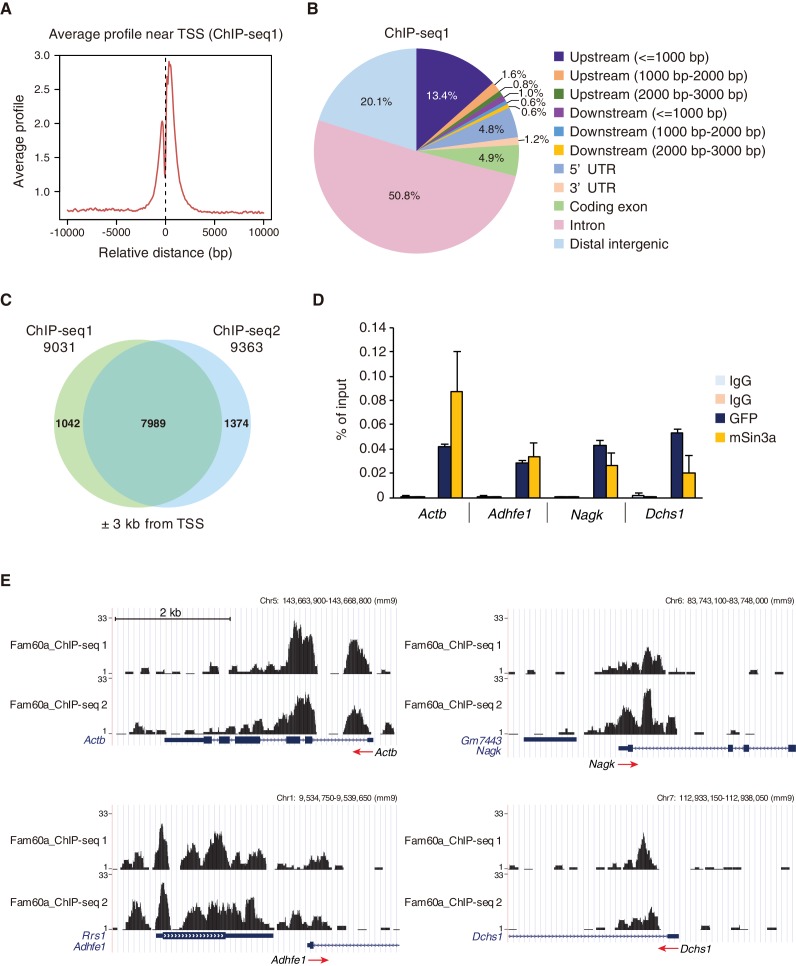
Genome-wide localization of Fam60a to gene promoters.(A) Average binding profile for Fam60a-Venus at the TSS region of all genes with binding peaks identified by ChIP-seq analysis of E9.5 transgenic embryos with antibodies to GFP. Distance is expressed relative to the TSS. (B) Peak distribution for ChIP-seq analysis as in (A). About 80% of peaks were localized to gene loci. UTR, untranslated region. (C) Venn diagram showing the overlap in Fam60a target genes (those with binding peaks within ±3 kb of the TSS) for two independent ChIP-seq analyses (ChIP-seq1 and ChIP-seq2). (D) ChIP-qPCR analysis of the binding of Fam60a-Venus and Sin3a to the TSS regions of the indicated genes in E9.5 transgenic and WT embryos, respectively. The pale blue and orange bars represent IgG controls for antibodies to GFP and to Sin3a, respectively. Data are expressed as percentage of input and are means ± s.d. for three independent experiments. Actb was examined as a positive control. (E) Examples of Fam60a-Venus ChIP-seq results for E9.5 Fam60a-Venus embryos. ChIP-seq1 and ChIP-seq2 were both performed with antibodies to GFP. Peaks around the TSS are shown for four Fam60a target genes, with red arrows indicating the direction of transcription. See also Figure 5—figure supplements 1 and 2.10.7554/eLife.36435.028Figure 5—source data 1.List of target genomic regions identified by ChIP-seq analysis.10.7554/eLife.36435.029Figure 5—source data 2.Numerical data of Figure 5D.10.7554/eLife.36435.030Figure 5—source data 3.Numerical data of Figure 5—figure supplement 2.